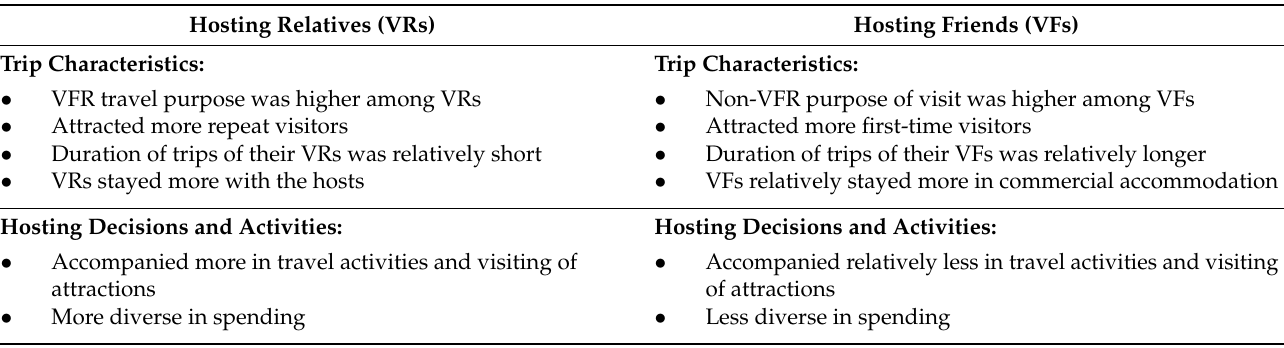
Table 10. Summary of significant differences between hosting friends and